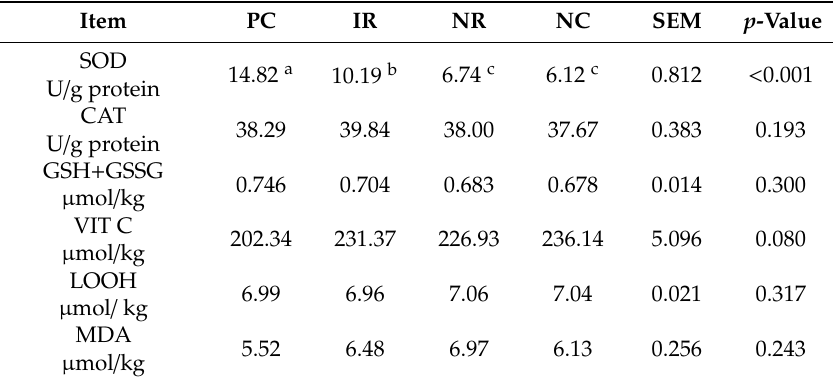
Table 10. Indicators of redox status in the bursa of Fabricius in